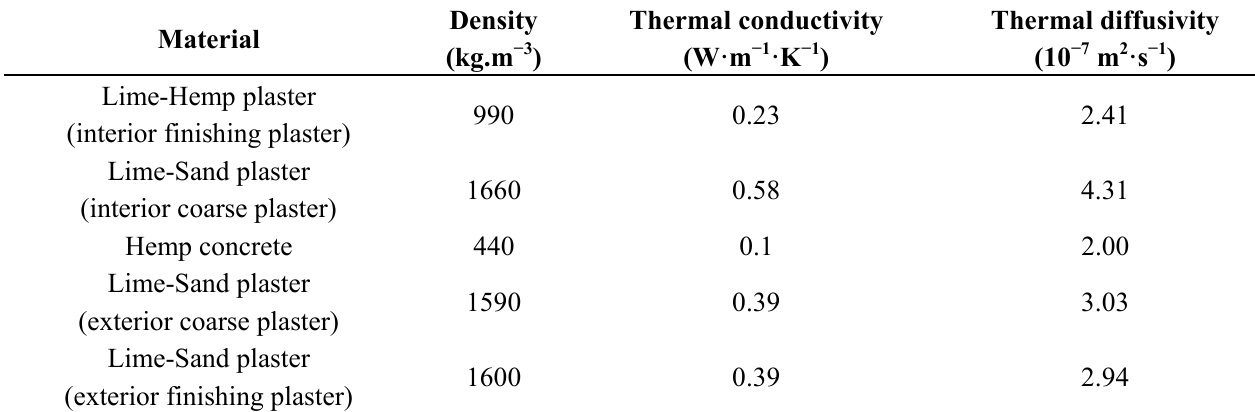
Table 4. Thermal properties of hemp concrete and plasters used for simulation.